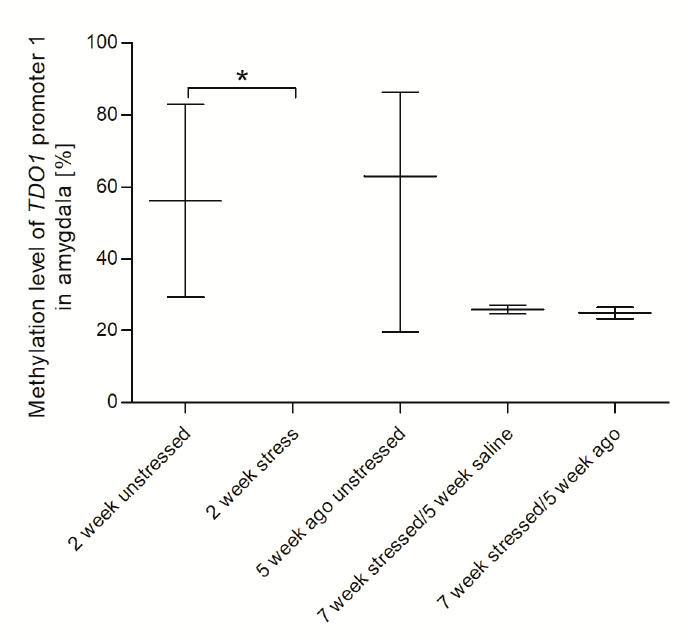
Figure 4. Methylation status of Tdo2 promoter 1 in the amygdala of CMS rats for two weeks (2 week unstress, 2 week stress) and in rats exposed to CMS for seven weeks and treated vehicle (1 mL / kg) or agomelatine (10 mg / kg) for five weeks (5 week agomelatine unstressed, 7 week stressed / 5 week saline, and 7 week stressed / 5 week agomelatine). Data represents means and min to max value. n = 6. * p < 0.05 for di ff erences between 2 week stressed and 2 week unstressed groups.